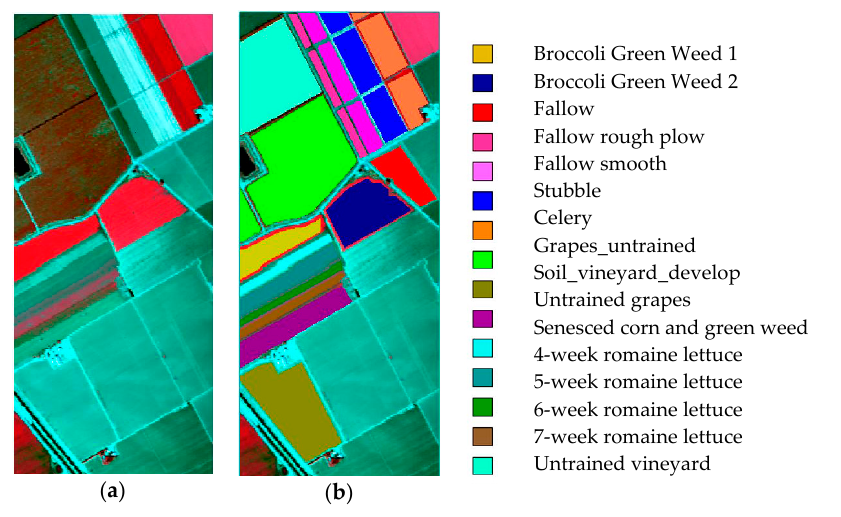
Figure 9. Salinas dataset: ( a ) False color composite of the AVIRIS image; ( b ) Ground truth map.